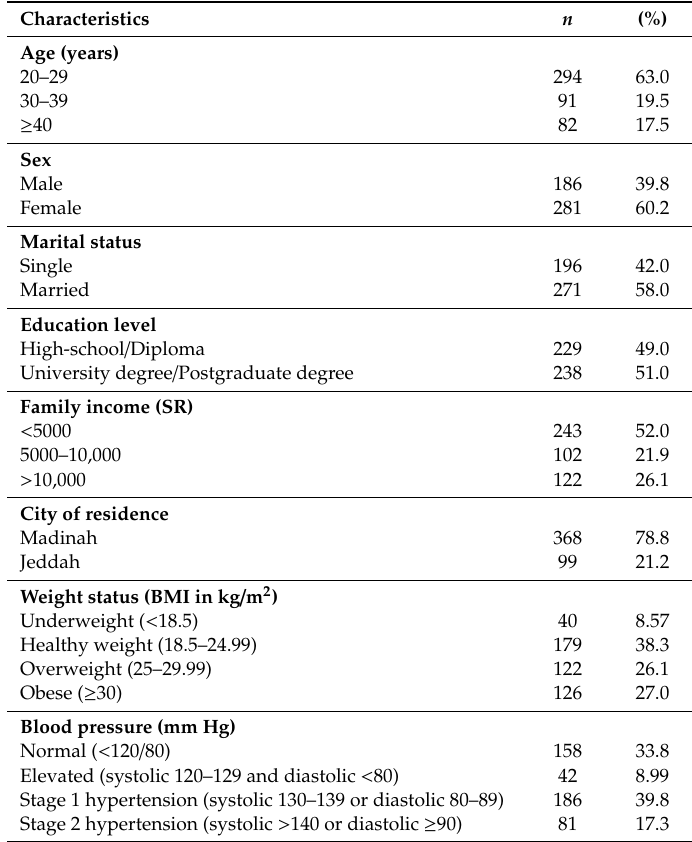
Table 1. Sociodemographic and physical characteristics of the participants (n =